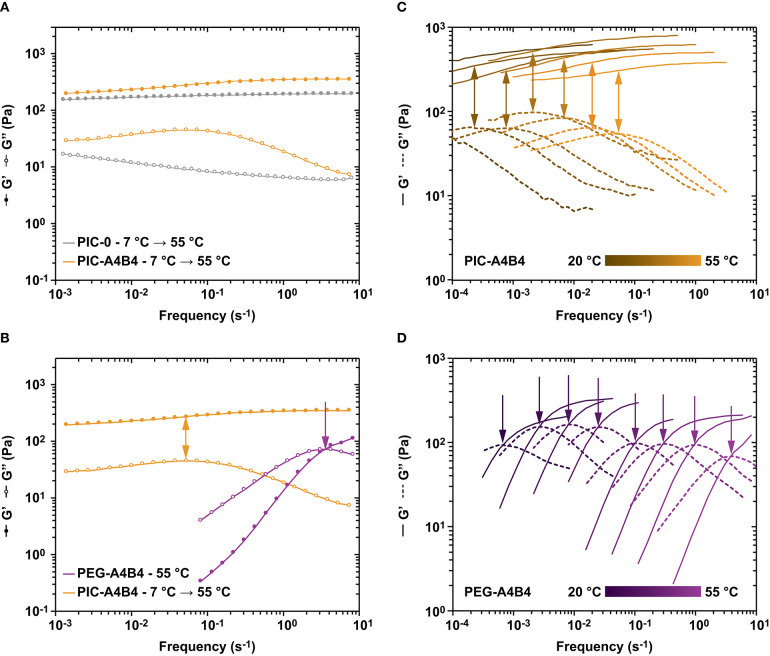
Frequency sweeps of PIC and PEG hydrogels. (A) Comparison of PIC-A4B4 and PIC-0 subjected to temperature protocol 1. Lines are drawn to guide the eye. (B) Comparison of PIC-A4B4 (temperature protocol 1) and PEG-A4B4 (measured at 55°C). Lines are drawn to guide the eye. (C) Comparison of the viscoelastic properties of PIC-A4B4 at different temperatures, ranging from 20 to 55°C. (D) Comparison of the viscoelastic properties of PEG-A4B4 at different temperatures, ranging from 20 to 55°C. For the PIC hydrogels, each frequency sweep was performed at a strain amplitude of 1%, while it was set to 10% for the PEG hydrogels. These strain amplitudes are in the linear viscoelastic range of each respective hydrogel. The frequency was varied from 0.0001 to 10 s−1. Additional data sets are shown in Supplementary Figure 6.